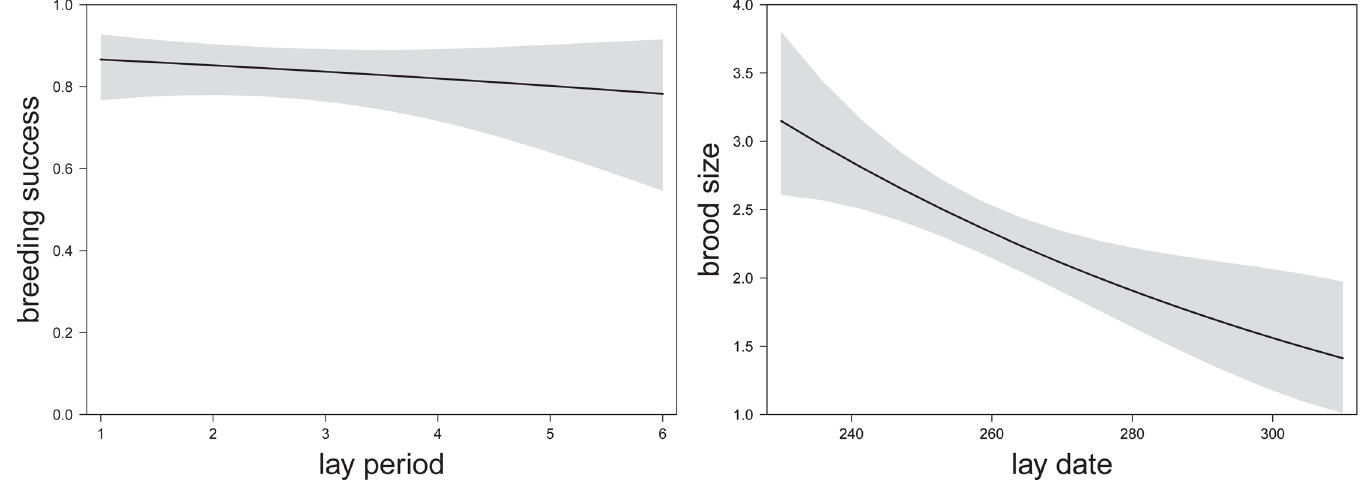
Fig 5. The relationship between (a) breeding success (binary part; estimate -0.11 ± 0.15 SE, χ 2 (n = 399) = 0.55, P = 0.456); and, (b) fledged brood size (1–4 young, truncated part; estimate -0.19 ± 0.05 SE, χ 2 (n = 316) = 13.70, P < 0.001) and the timing of breeding, based on predicted values of Hurdle model on the full data set, 95% CIs in shaded grey. Model details in Table